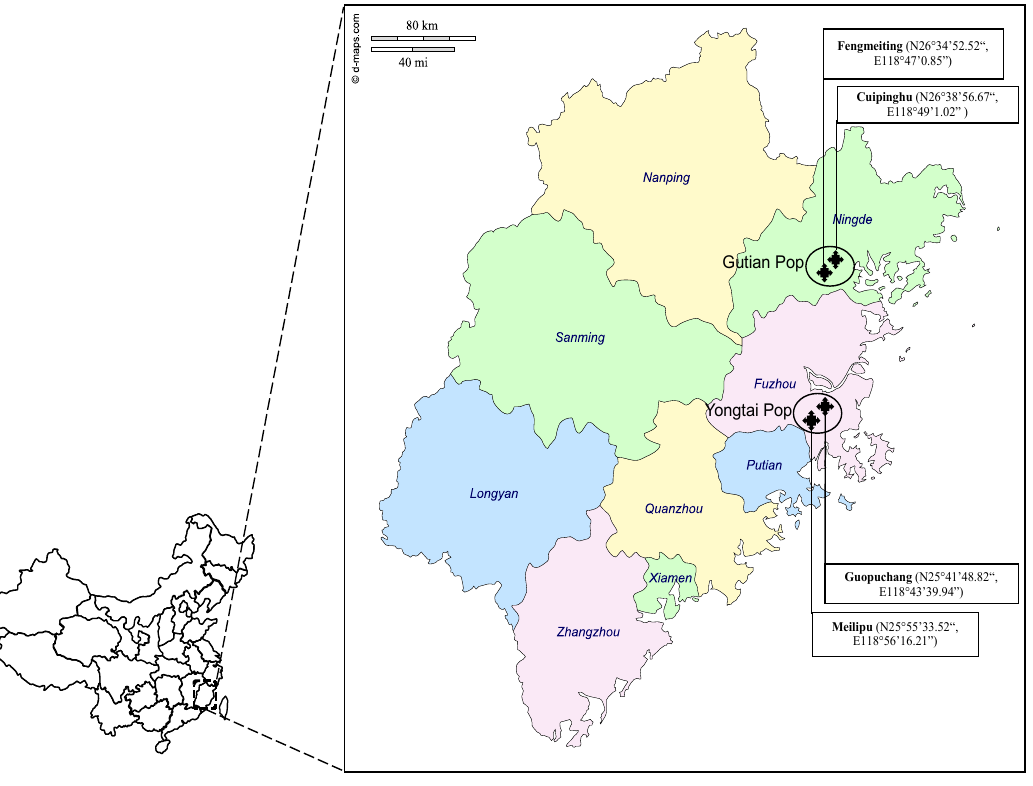
Figure 1. Geographical regions of 33 plum varieties (Table 1) collected from Gutian as Gutian population (Cuipinghu subpopulation and Fengmeiting subpopulation) and Yongtai as Yongtai population (Guopuchang subpopulation and Meilipu subpopulation) in Fujian Province, China.